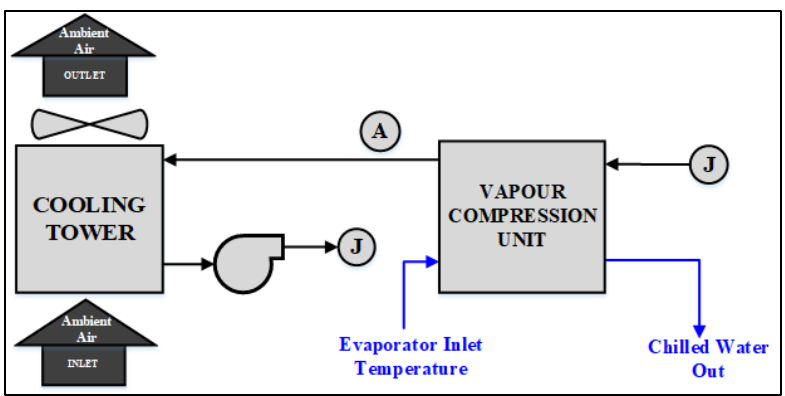
Figure 1. Conventional configuration of an air conditioning chiller.